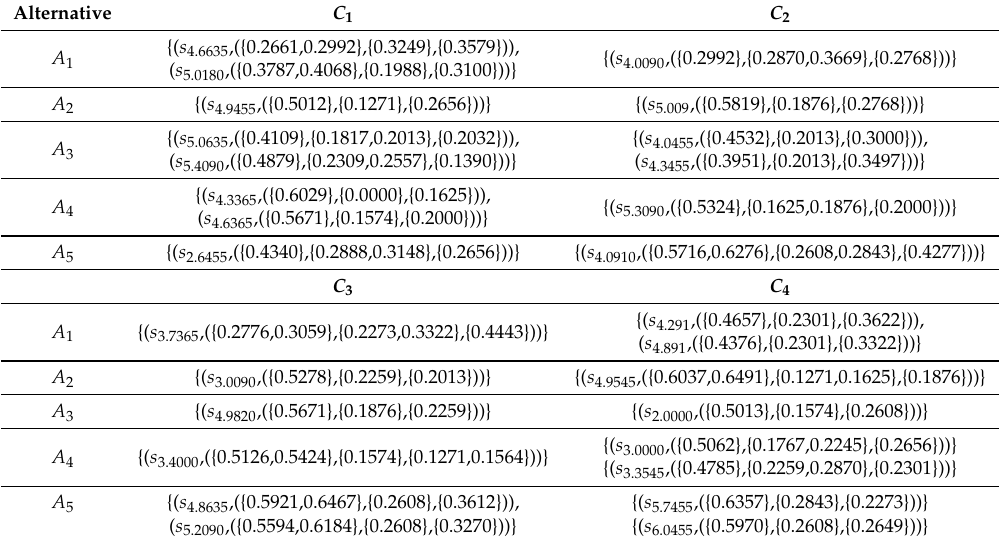
Table 4. Collective decision matrix D .